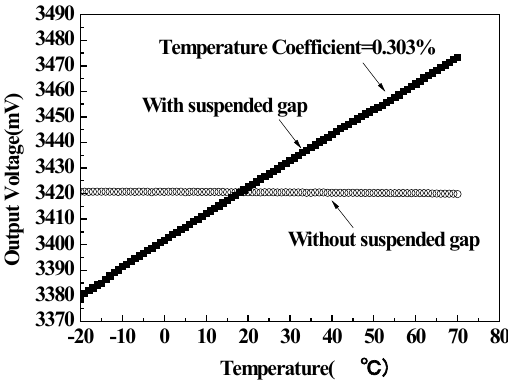
Figure 5. The response of the sensor platform from − 20 to 70 °C.